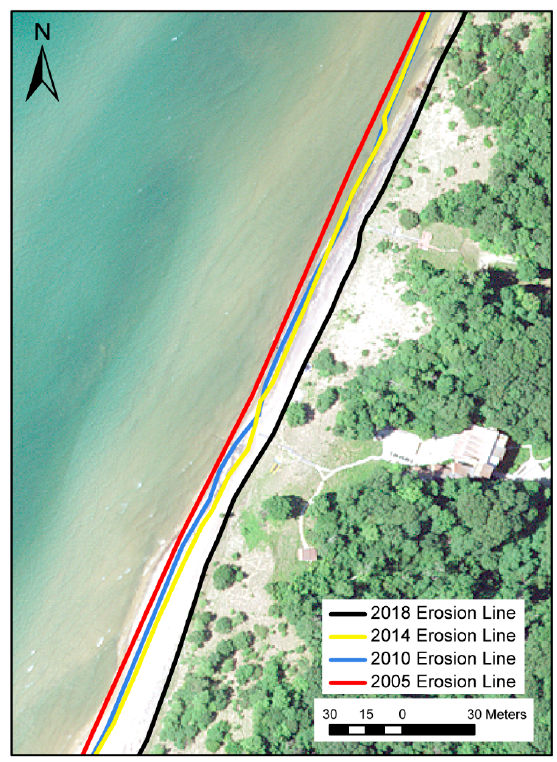
Figure 2. Example of method for erosion line mapping from Van Buren A2. The background aerial image is from 2018 and was downloaded from the United States Geological Survey (USGS) Earth Explorer. .